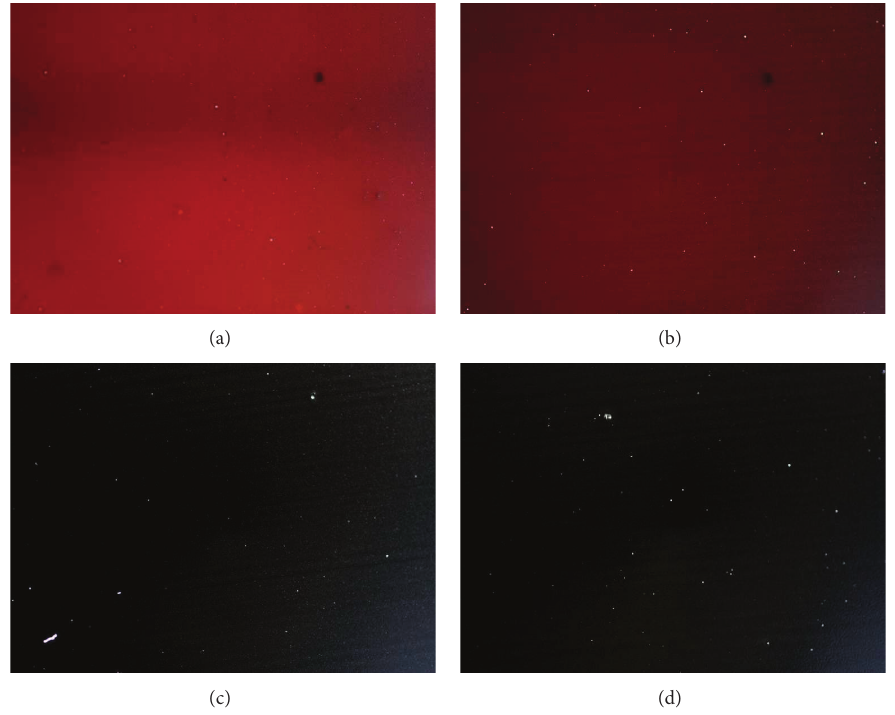
Figure 1: Polymerized films of the KL and HBL paints. (a) KL paint, (b) KL paint with ELO-6 at 10: 1 by weight, (c) HBL paint, and (d) HBL paint with ELO-6 at 10 :1 by weight.